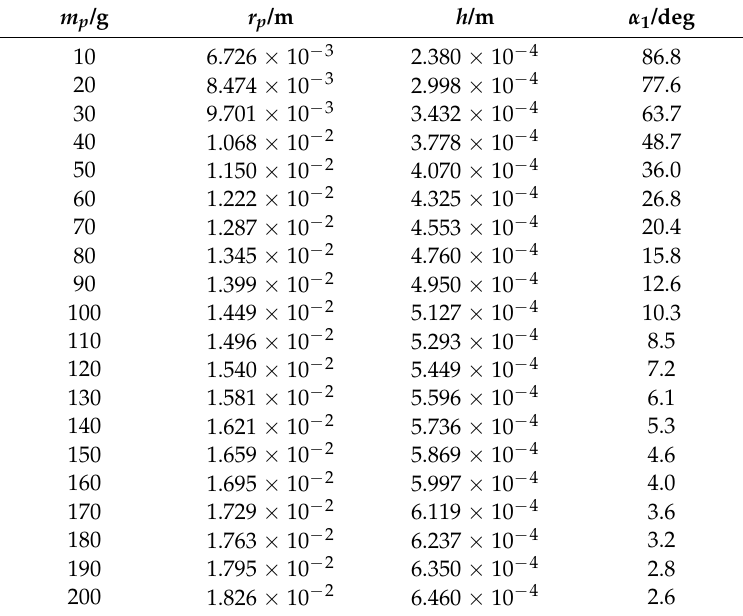
Table 2. The sliding angle for 35CrMo wall under different particle impacts. ( σ y = 8.35 × 10 8 Pa, E * = 2.34 × 10 11